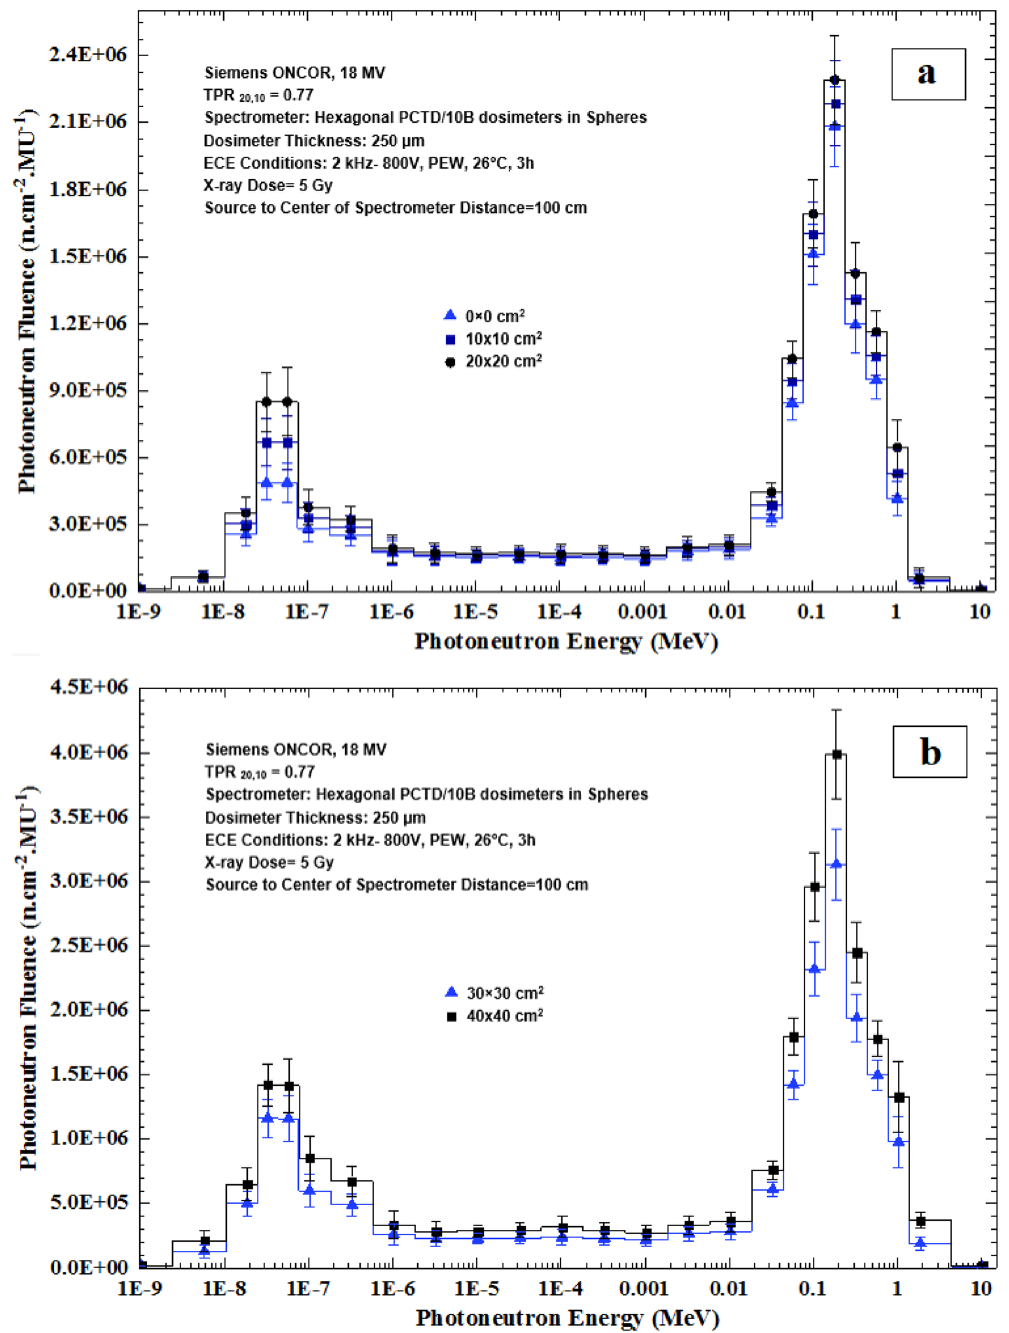
Figure 6. PN spectra of 5 field sizes; ( a ) 0 × 0, 10 × 10 and 20 × 20 cm 2 and ( b ) 30 × 30 and 40 × 40 cm 2 , by the PE sphere neutron spectrometry system developed as exposed at the isocenter to 5 Gy 18 MV X-ray